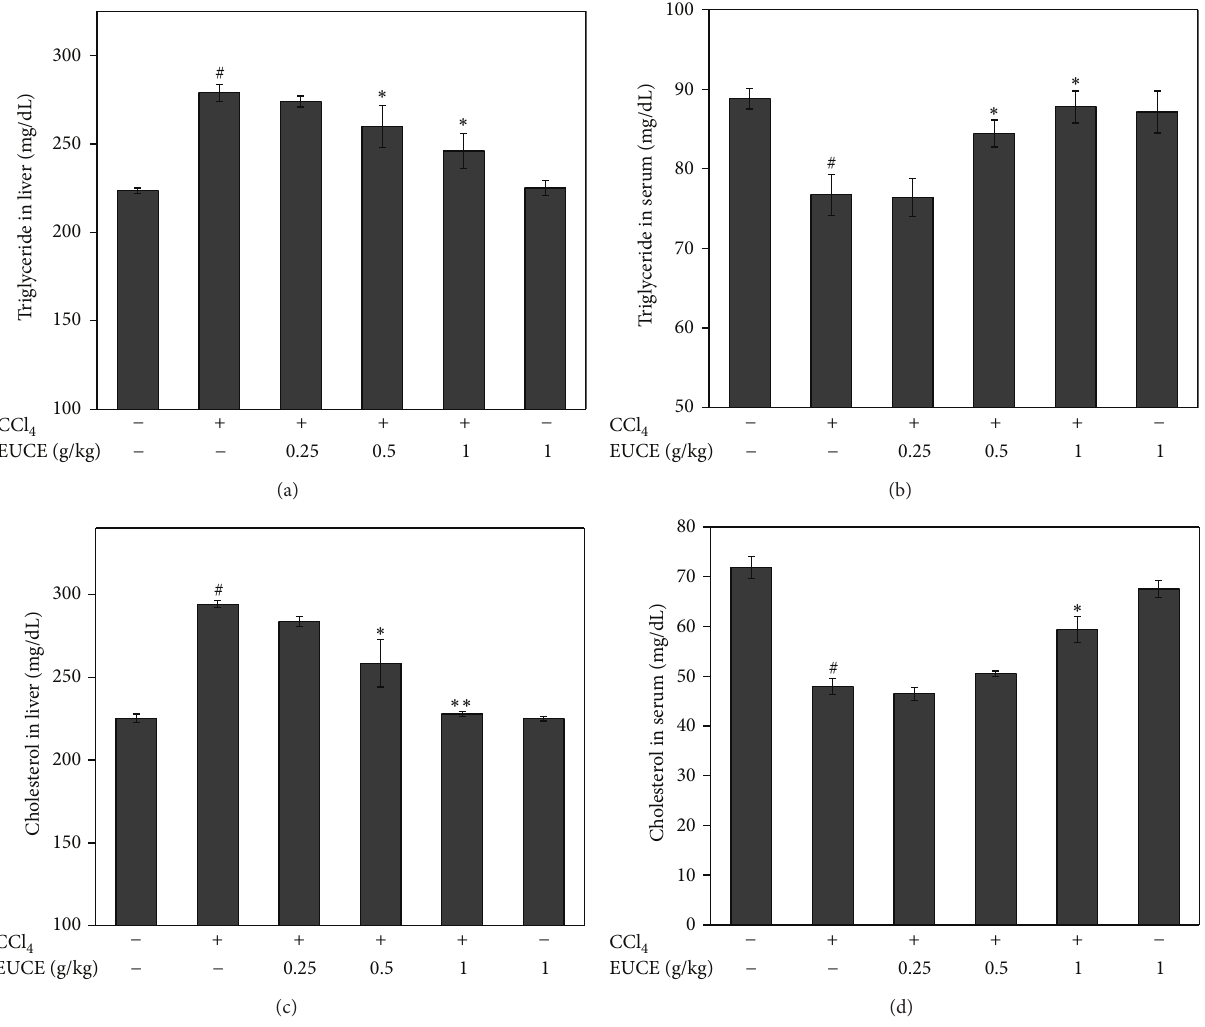
Figure 2: Effect of EUCE on CCl 4 -induced inhibition of hepatic triglyceride and cholesterol secretion. Rats were injected with 1mg/kg CCl 4 , and livers were isolated after 4 hours. Triglyceride and cholesterol levels were measured in the liver (a), (c) and plasma (b), (d), respectively. Values are mean ± SD, 𝑛 = 8 . Asterisks indicate differences from the group treated with CCl 4 only ( ∗ 𝑃 < 0.05 ; ∗∗ 𝑃 < 0.001 ). # 𝑃 < 0.05 indicates a significant difference compared with the control